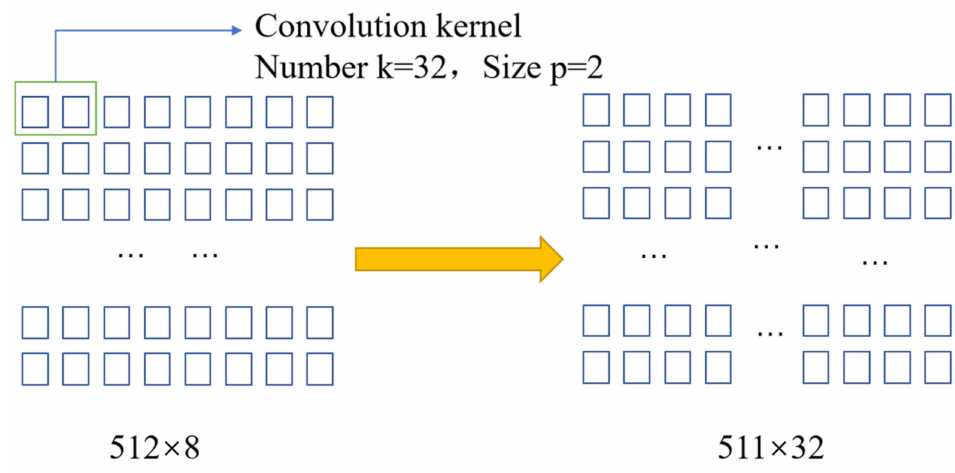
Figure 2. 1D convolution